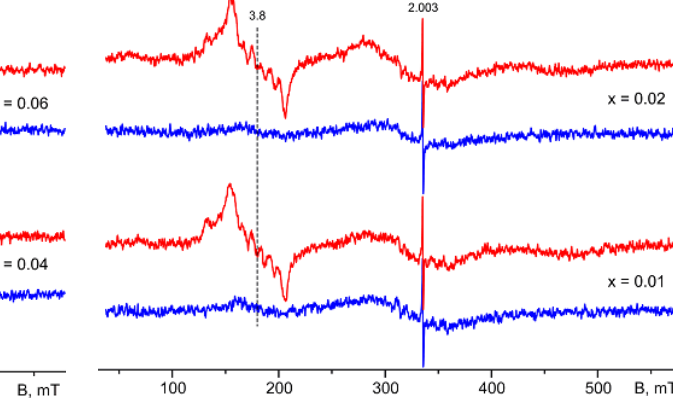
Figure 9: ESR spectra of BiNb 1− x Mn x O 4− δ (x=0.01 and 0.02) solid solution samples of triclinic (red, 1100 ∘ C) and of orthorhombic (blue, 750 ∘ C)